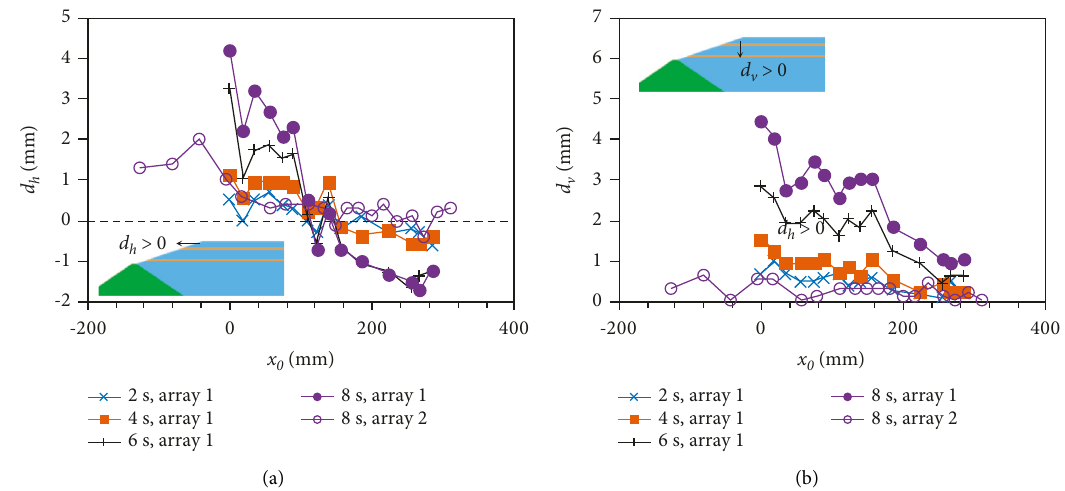
Figure 7: Horizontal distributions of (a) horizontal displacement d stage